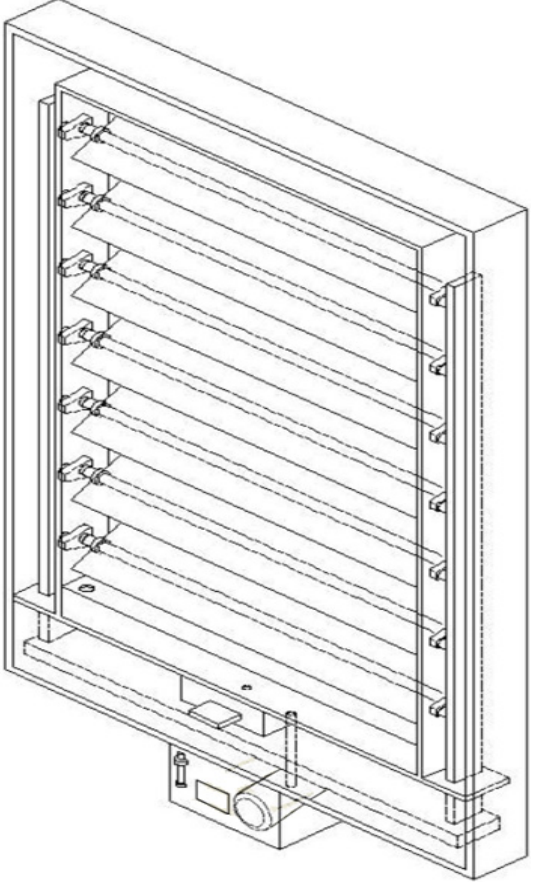
Figure 5. Relief assembly drawing of the shading